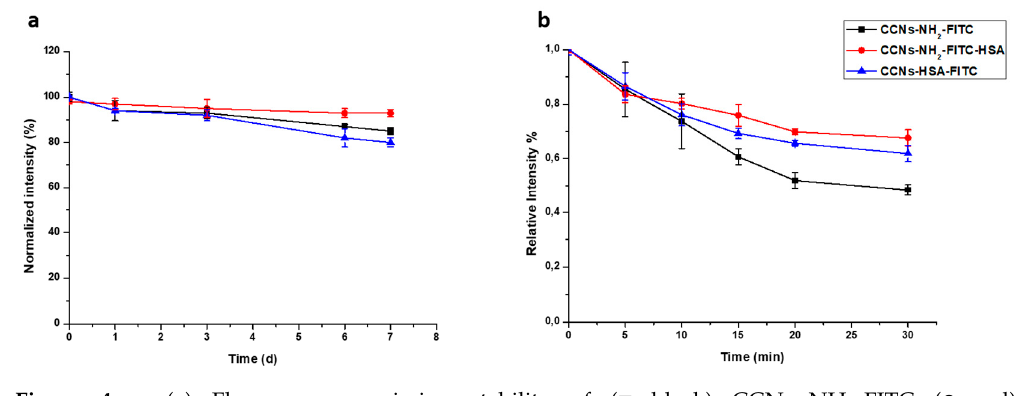
Figure 4. ( a ) Fluorescence emission stability of ( ■ black ) CCNs − NH 2 -FITC ( ● red) CCNs − NH 2 -FITC- HSA, ( ▲ blue ) CCNs-HSA-FITC in PBS at 37 °C. The error bars report the standard deviation of the measurements (three replicates). (b ) The fluorescence intensity in MCF-7 cells was determined by staining with FITC-coupled samples by confocal microscopy. The fluorescence intensity evolution in the consecutive t-scan mode ( ʎ em = 488 nm) was monitored at 2 minutes intervals for a total of 30 minutes. Data were obtained from replicate (n = 5) experiments.